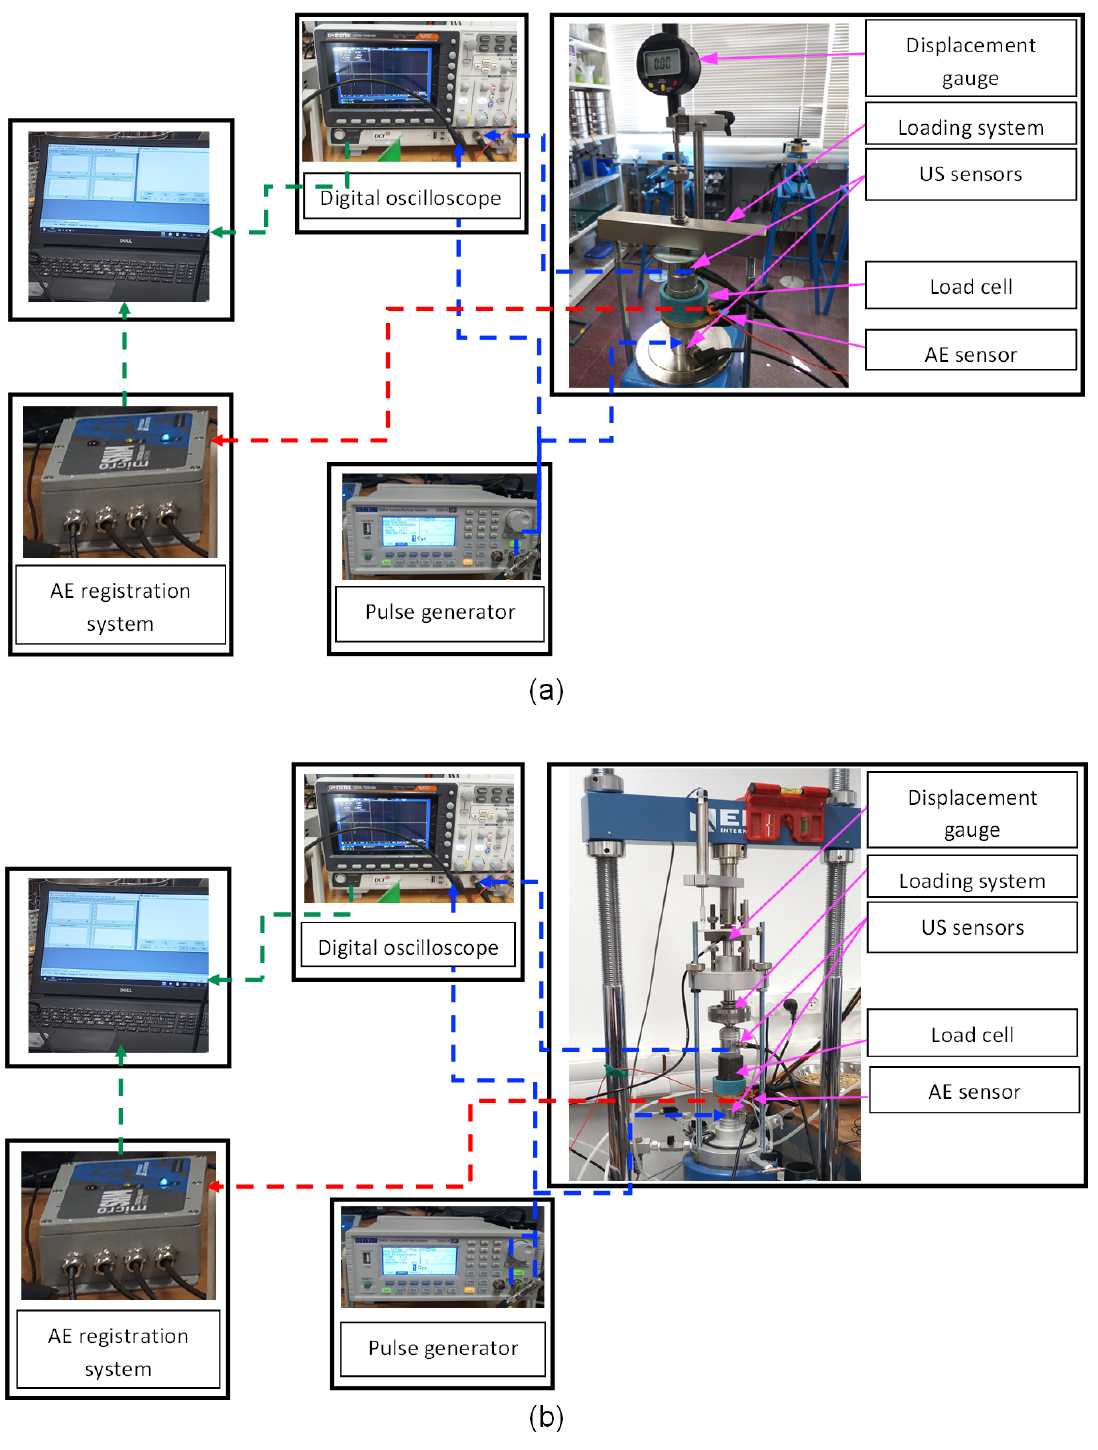
Figure 3. The experimental setup for the ultrasonic and acoustic emission study. ( a ) The oedometer with dry sand samples (OD) test. ( b ) The modified uniaxial compression test with passive confinement using dry sand samples (UCD) and modified uniaxial compression test with passive confinement using wet sand samples (UCW) tests. For the explanation of these abbreviations, see Section